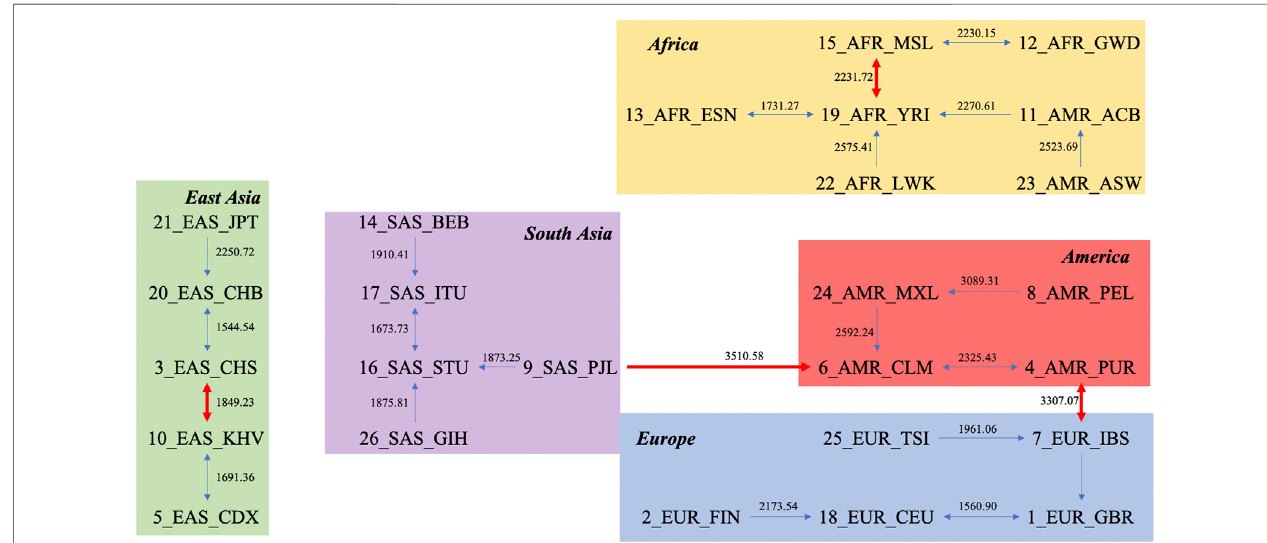
FIGURE 2 | Natural graph based on the distance matrix obtained by the DNV